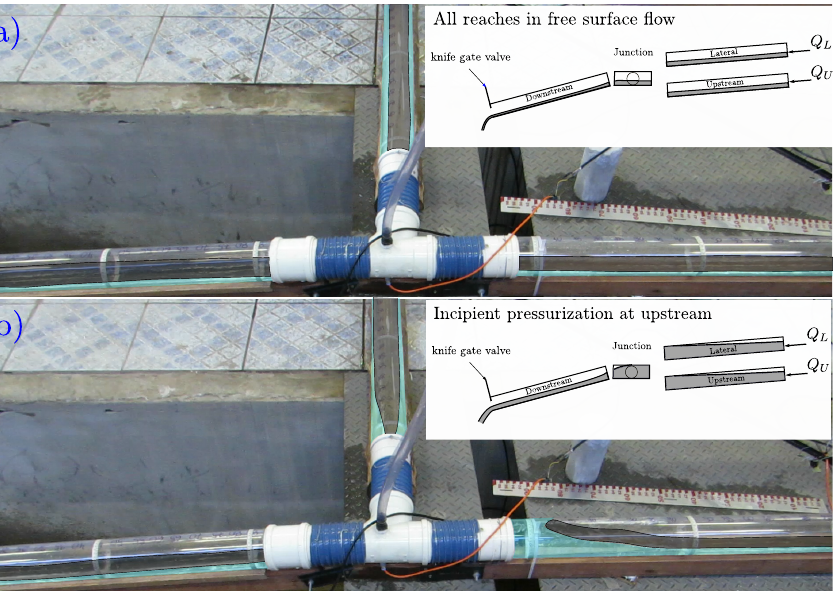
Figure 2. Pictures for flow initial conditions immediately prior to the knife gate valve closure: ( a ) Free surface flow condition; ( b ) Incipient pressurization